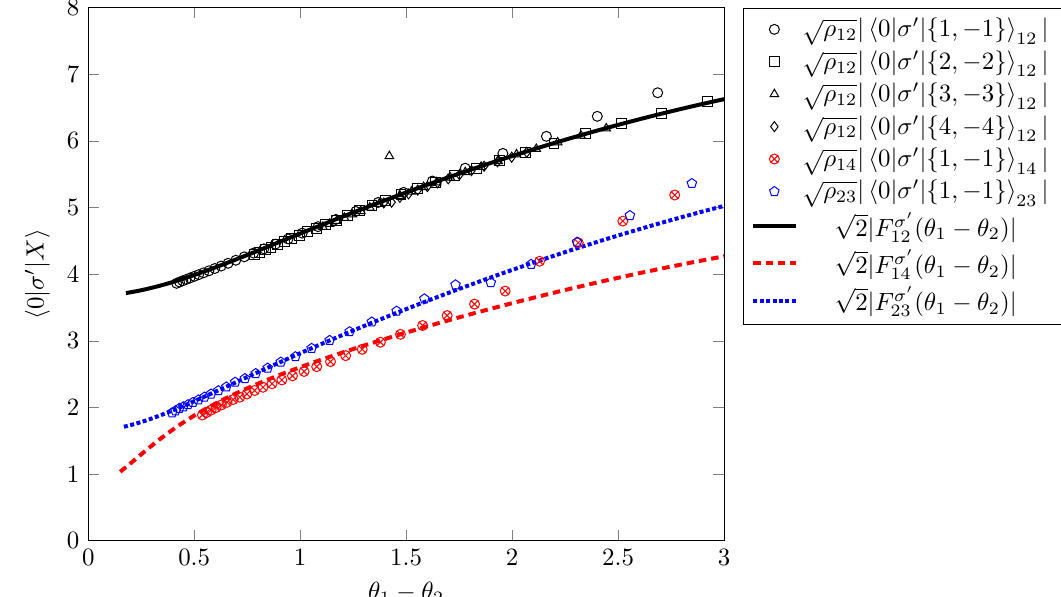
Figure 6.4: Rescaled vacuum-two-particle matrix elements of σ (cid:48) (discrete markers) plotted against the rapidity difference and compared to the exact form factors ob- tained from the bootstrap (shown with lines). Form factors of 12 states of larger quantum numbers are better fit in large rapidities, due to smaller finite size effects. For twp-particle states 14 and 23 states we could only identify the lowest levels for each, since the higher ones are deeply in the continuum of 12 states, which makes their identification